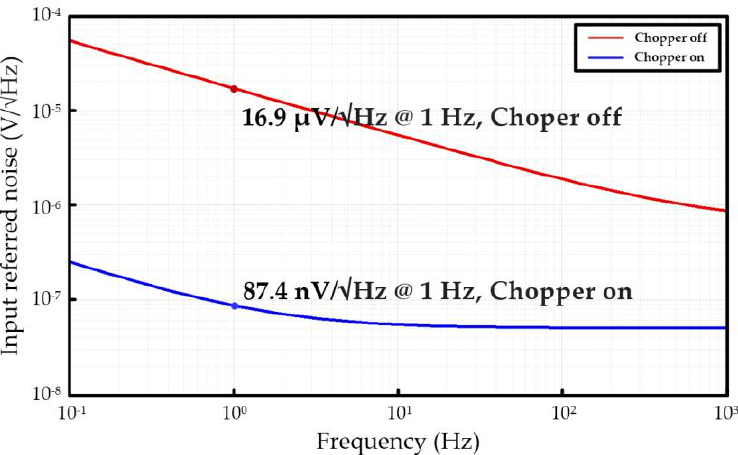
Figure 15. Input-referred noise simulation result of readout IC. The IRN measurement of the fabricated readout IC is shown in Figure 16. Measurement of the IRN is performed by implementing a dynamic signal analyzer in the range of 0.5 Hz to 200 Hz. The simulated and measured IRNs were 87.4 nV√Hz and 95.4 nV/√Hz at 1 Hz, respectively.